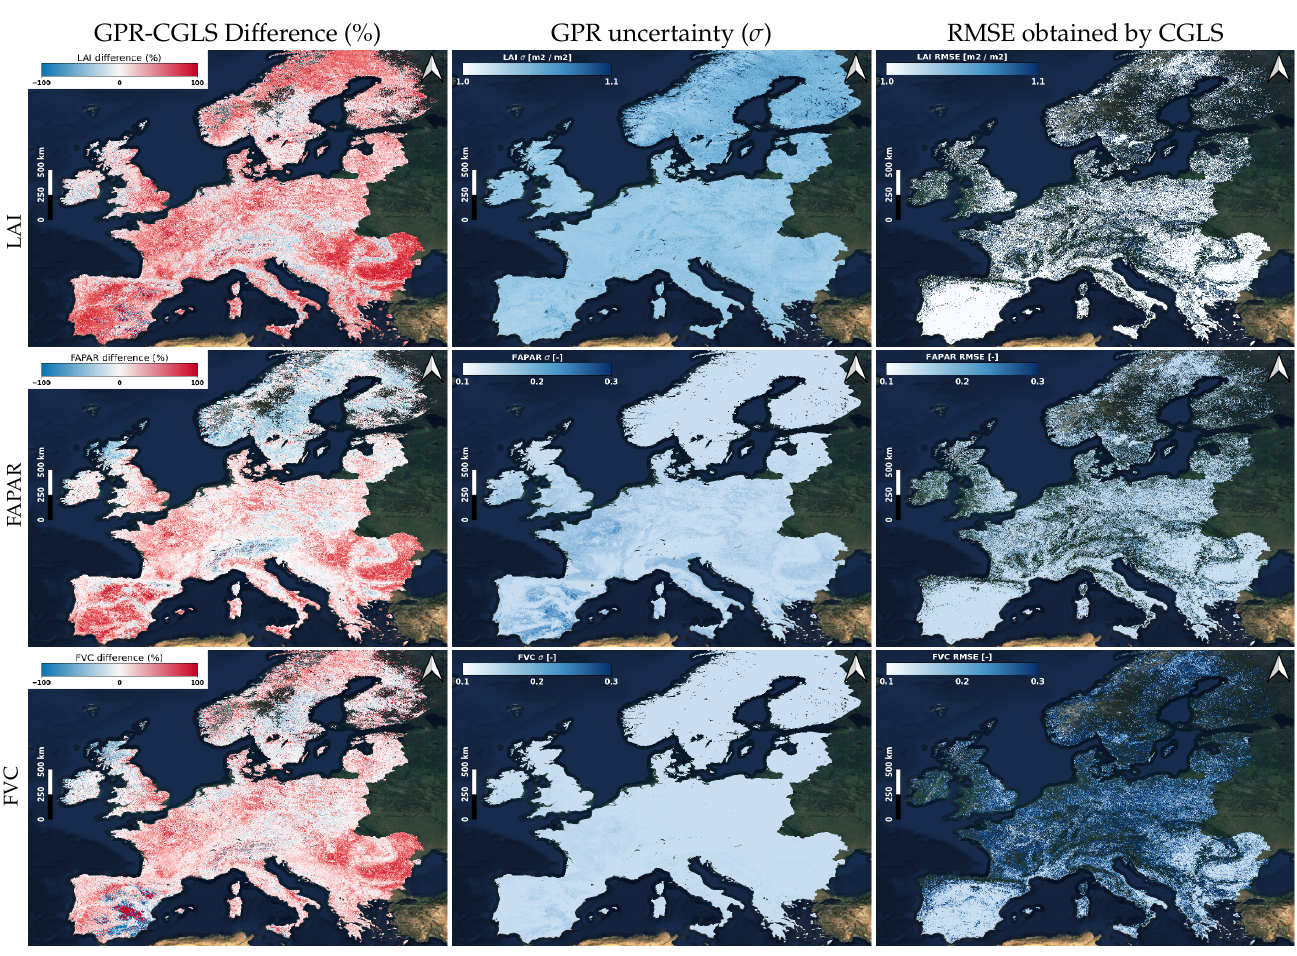
Figure 8. Comparison maps between CGLS and S3-TOA-GPR-1.0 models for a monthly averaged composed map between 4 March 2019 and 20 November 2019. In columns: maps of GPR-CGLS percentage differences ( left ), uncertainty ( σ ) obtained by GPR ( middle ) and RMSE obtained by CGLS ( right ). In rows: maps of LAI ( top ), FAPAR ( middle ) and FVC ( bottom